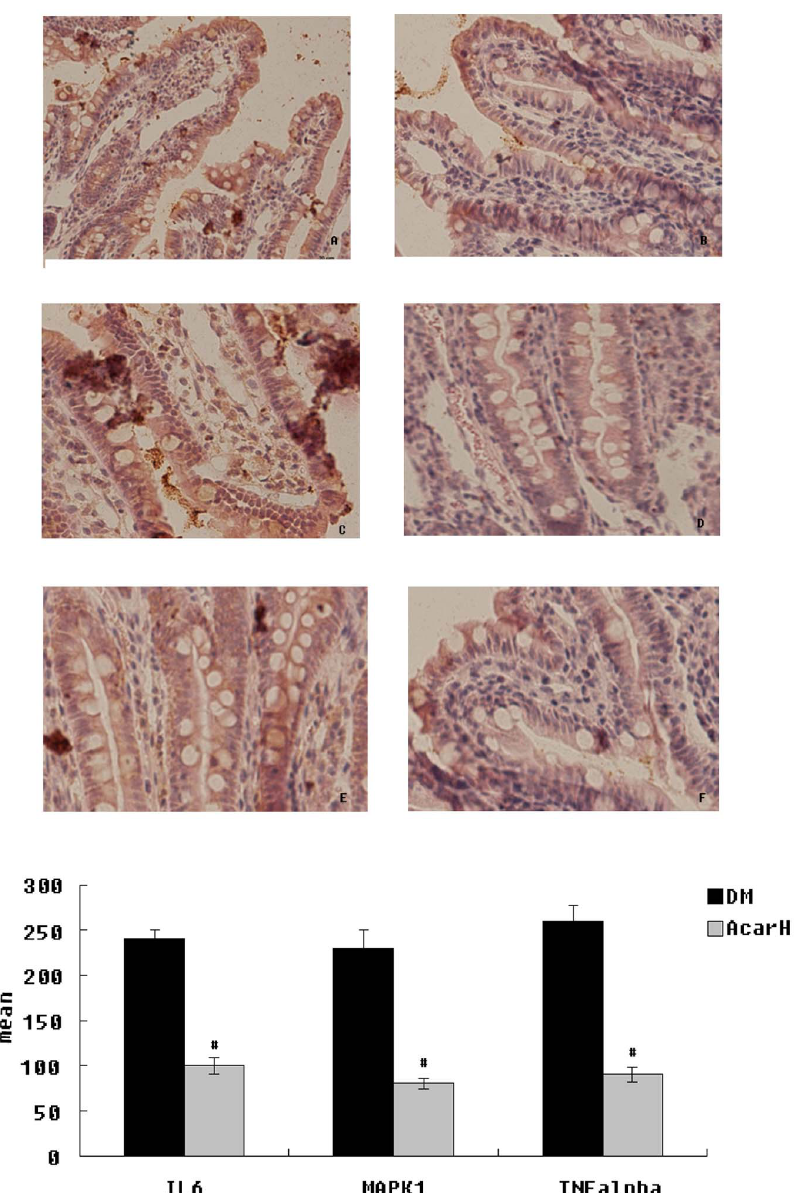
Figure 6. Iluem immunohistochemistry for IL6, MAPK1 and TNF- a expression (original magnification 6 200) and semiquantitative assessments. Immunostaining for IL6 (A–B), immunostaining for MAPK1 (C–D), immunostaining for TNF- a (E–F). Iluem were harvested form DM (A, C, E) and AcarH group (B, D, F). Semiquatitatve scores of IL6, MAPK1 and TNF- a (G). Data represent mean 6 SD (n=6). # P , 0.05 versus DM group. doi:10.1371/journal.pone.0079697.g006 PLOS ONE |